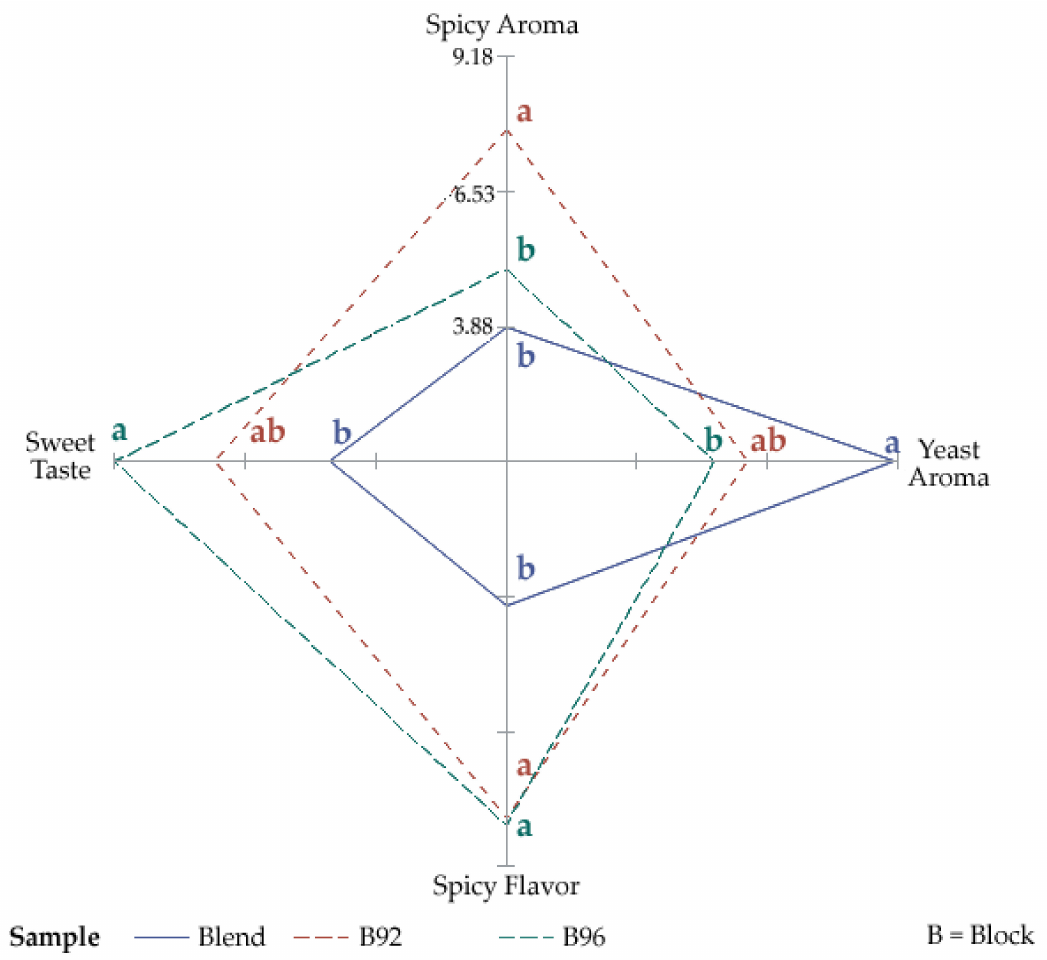
Figure 5. Spider chart of the sensory descriptors, showing the results of the ANOVA for the attributes, with significant di ff erences according to the Fisher’s least significant di ff erences (LSD) post-hoc test ( α = 0.05). Di ff erent letters (a,b) denote significant di ff erences among